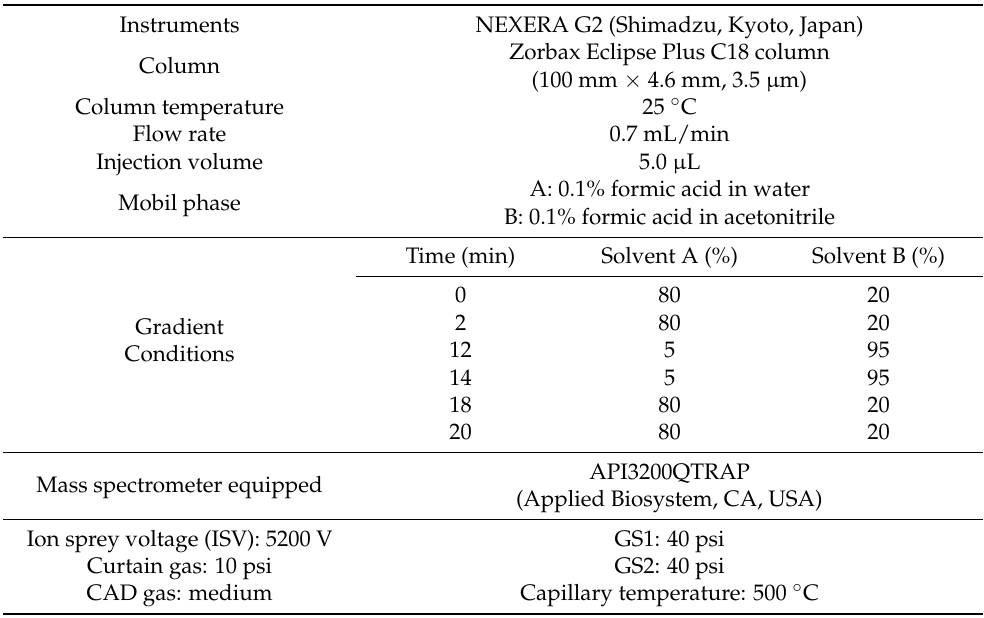
Table 1. The ultra-performance liquid chromatography with electrospray ionization mass spectrome- ter (UPLC-ESI-MS/MS) conditions for calycosin analysis.